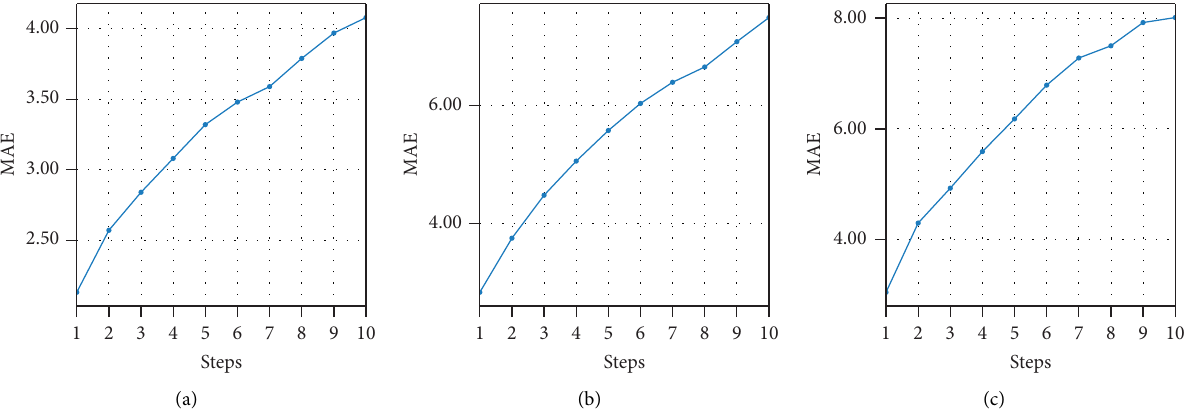
Figure 8: Multistep prediction MAEs of LSTM model on detector 16,395 with different time intervals. (a) 5-minute interval. (b) 10-minute interval. (c) 15-minute interval.